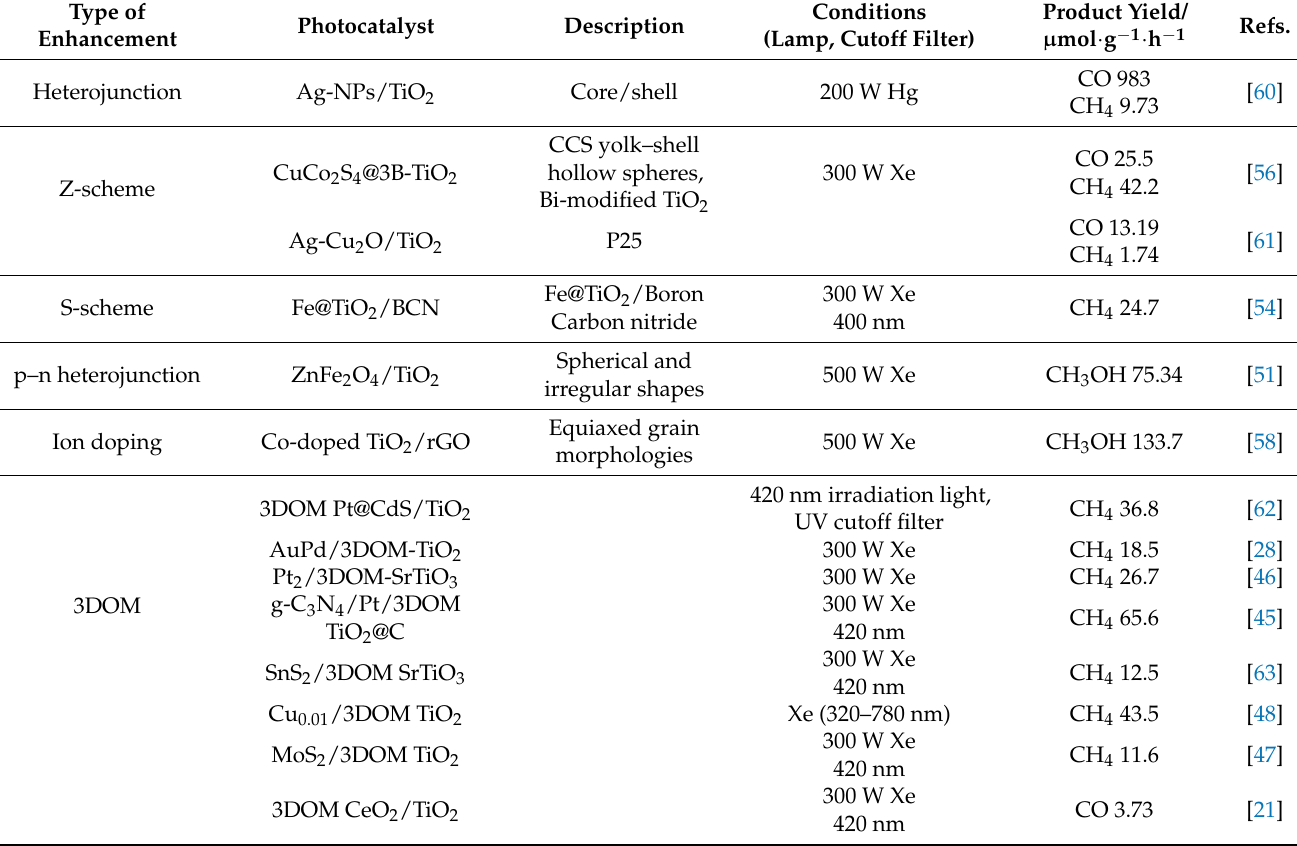
Table 1. Summary of the recent results of the photoreduction of CO 2 using TiO 2 -based